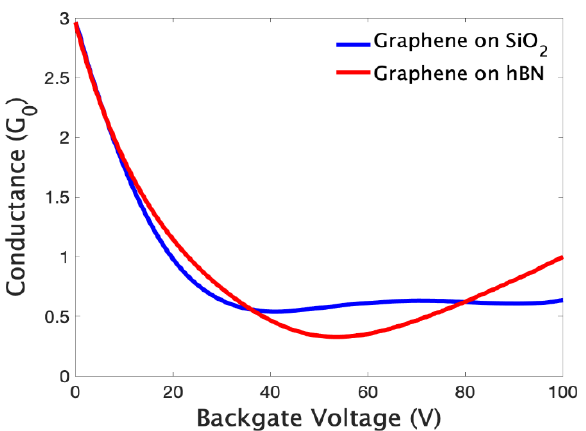
Figure 7. Device conductance in units of the quantum of conductance for graphene on SiO 2 and graphene on hBN/SiO 2 .